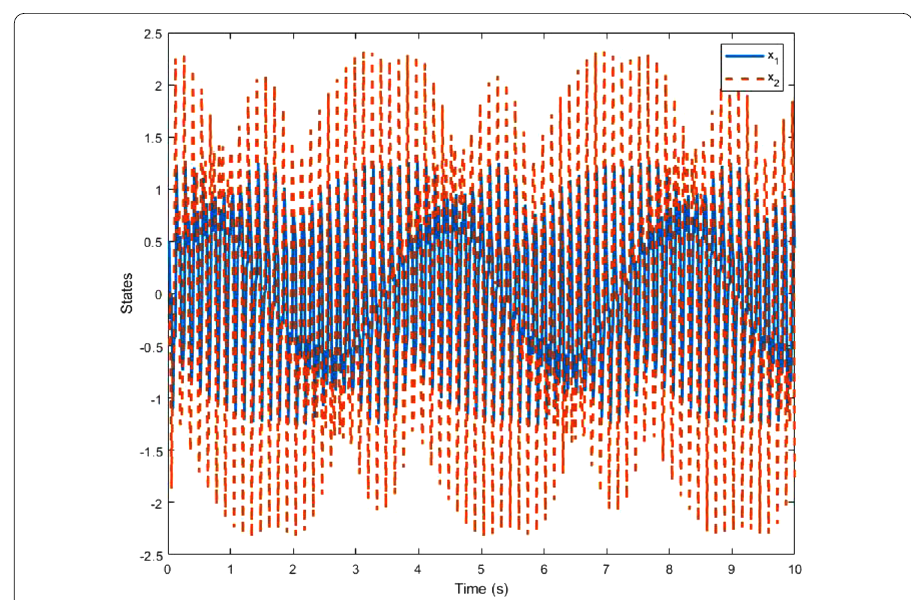
Figure 5 Dynamical behavior of the uncontrolled